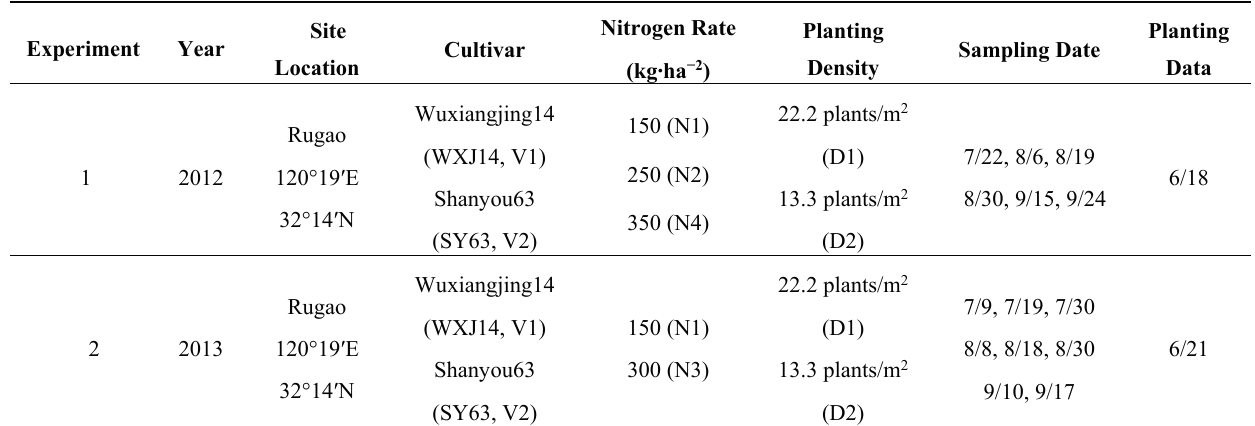
Table 1. Treatment and sampling information. N1, Nitrogen Rate